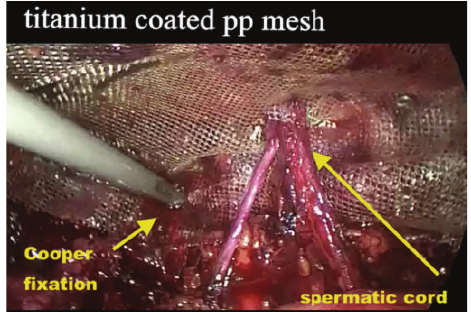
Figure 2: Placement of a new